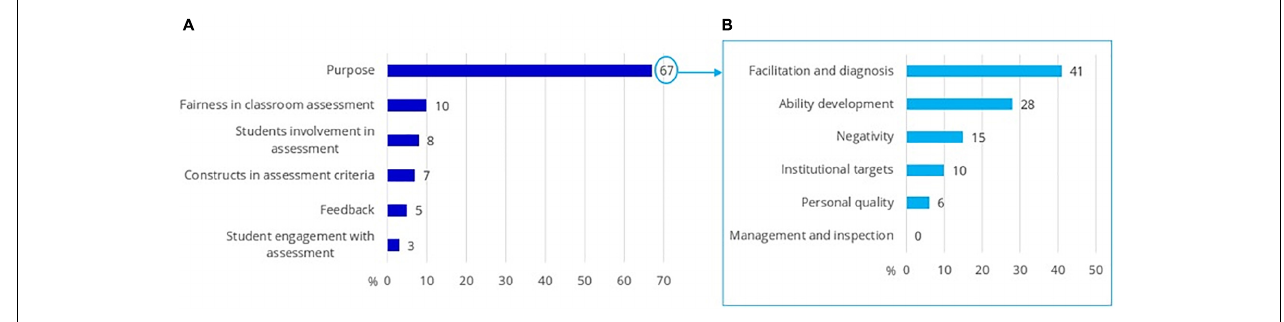
FIGURE 3 | (A) Targets of preservice teachers’ conceptions of assessment (f = 477 utterances). (B) Preservice teachers’ assessment conceptions regarding assessment purpose (f = 300): further analysis of a target of (A)